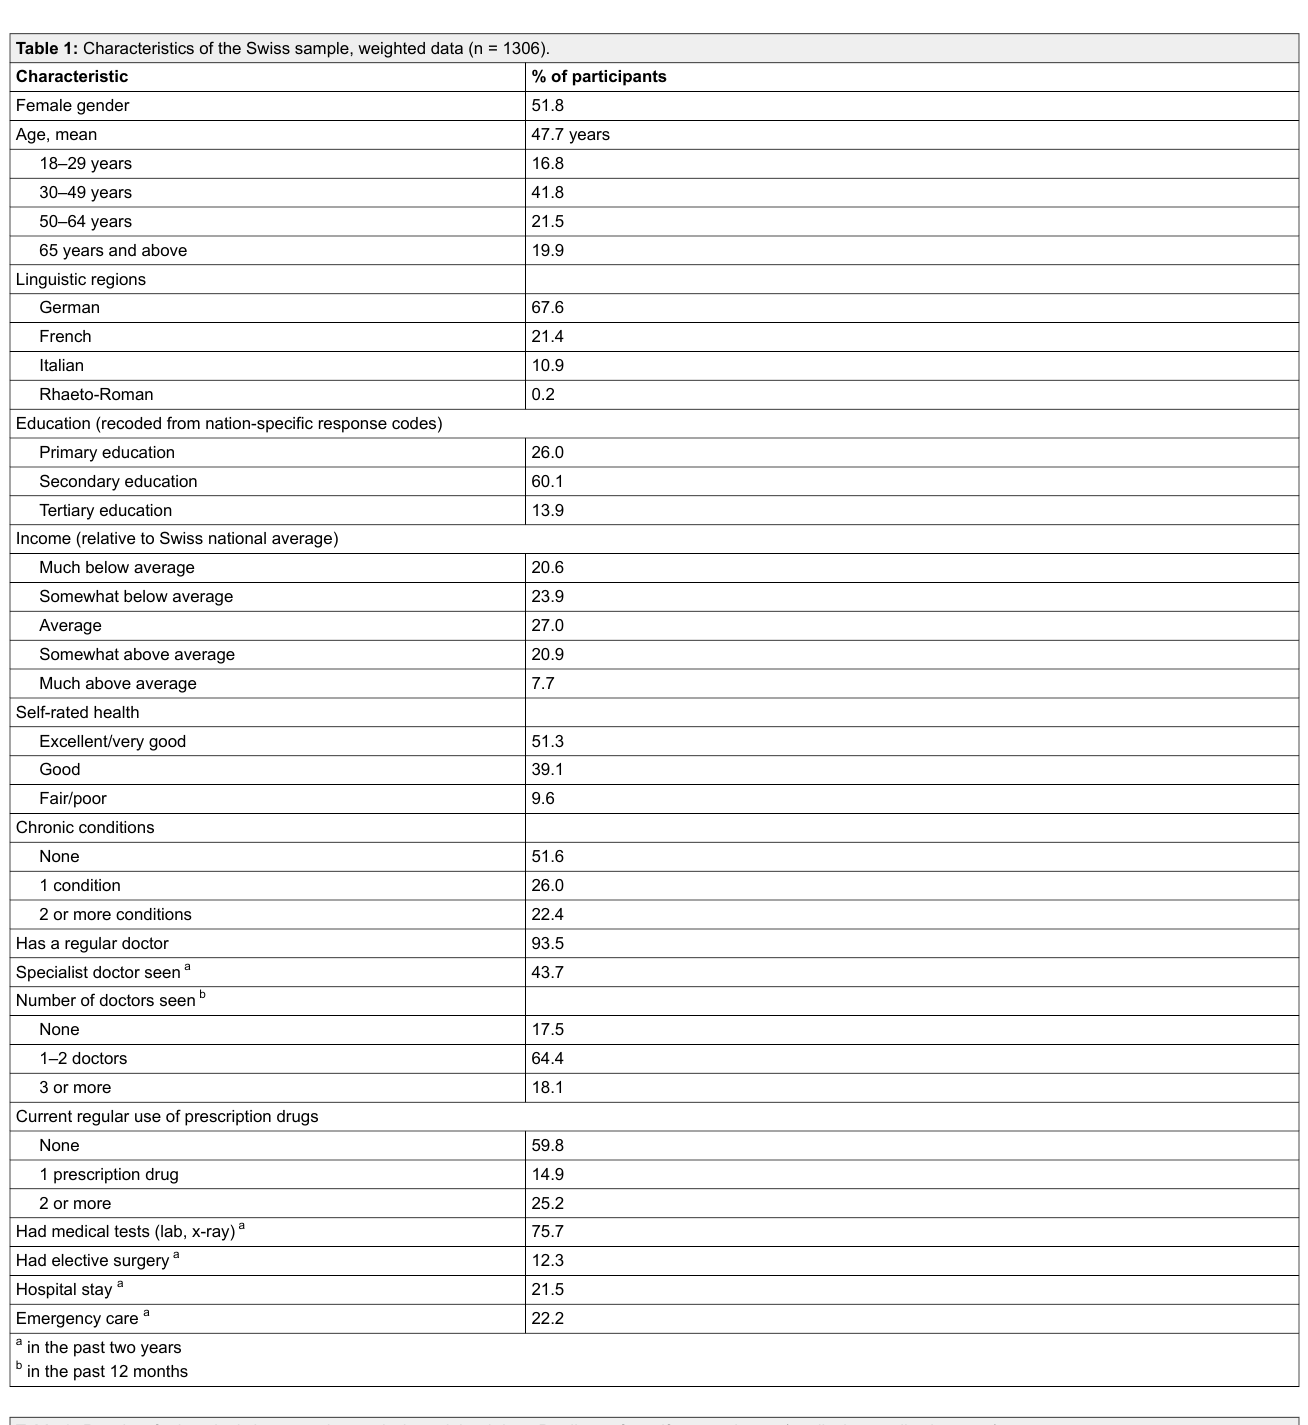
Table 2: Results of robust logistic regression analysis, weighted data. Predictors for self-reported error (medical or medication error).